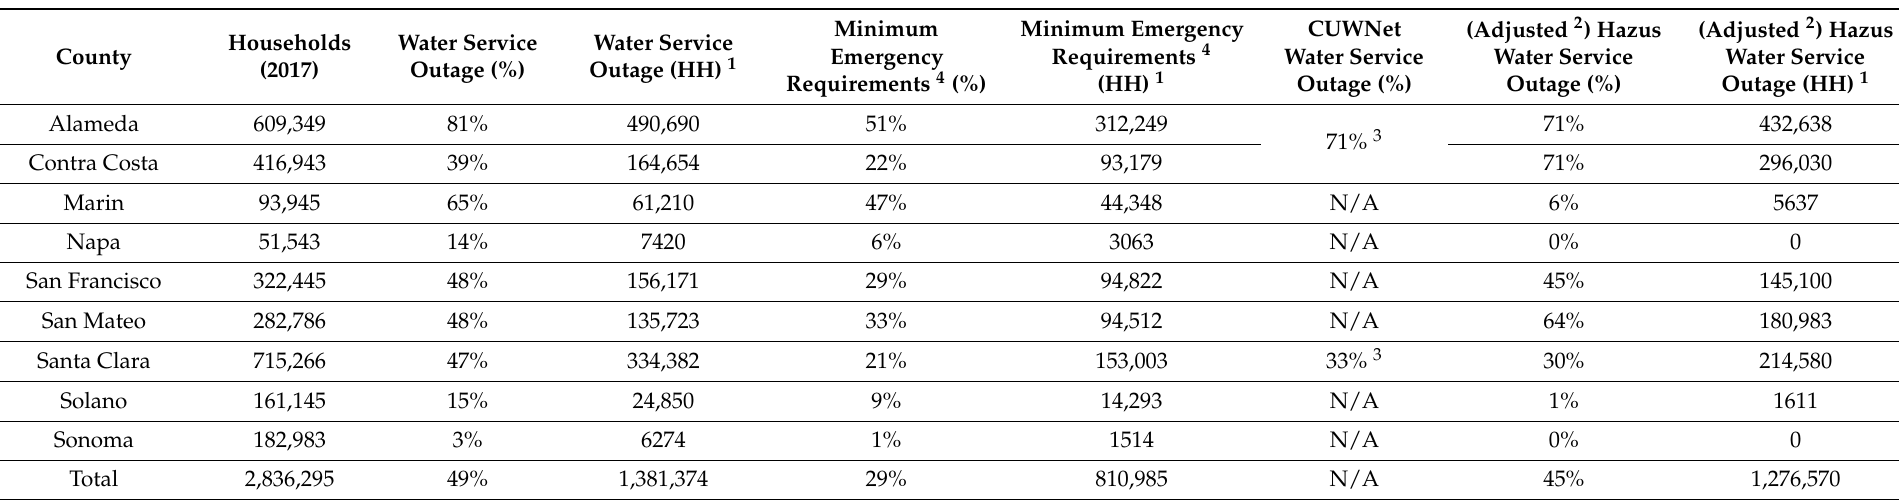
Table 2. Summary of results in the nine-county HayWired scenario study